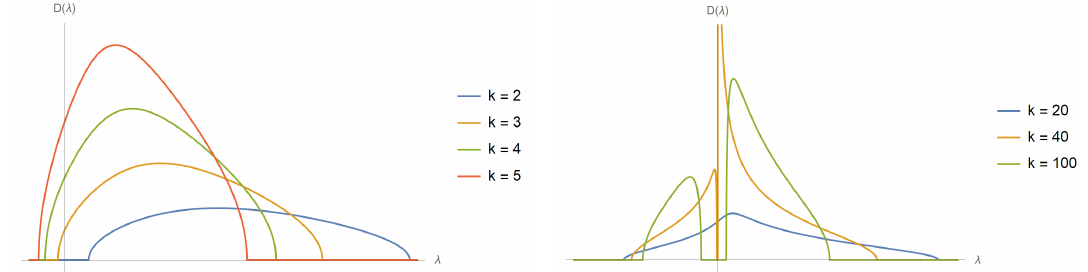
Figure 5 . Negativity spectrum in the microcanonical ensemble calculated from the cubic resolvent equation (5.3). We fix e S = 10 , k 2 = 2 , and move in a horizontal line in the phase diagram by tuning k . The disconnected-to-pairwise transition (left) occurs at k = e S = 10 , though we only plot to k = 5 for visual clarity, as the qualitative behavior is the same. The pairwise-to-cyclic transition (right) occurs at k = k 2 e S = 40 2